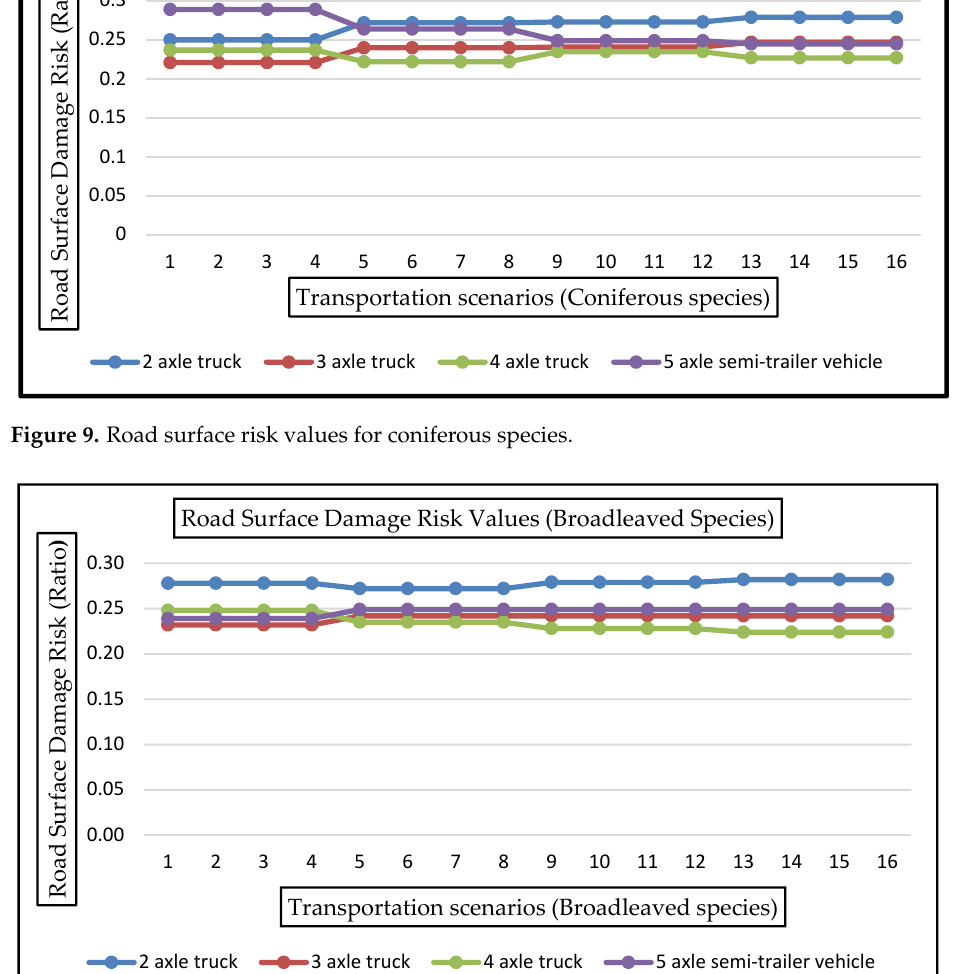
Figure 10. Road surface risk values for broadleaved species.